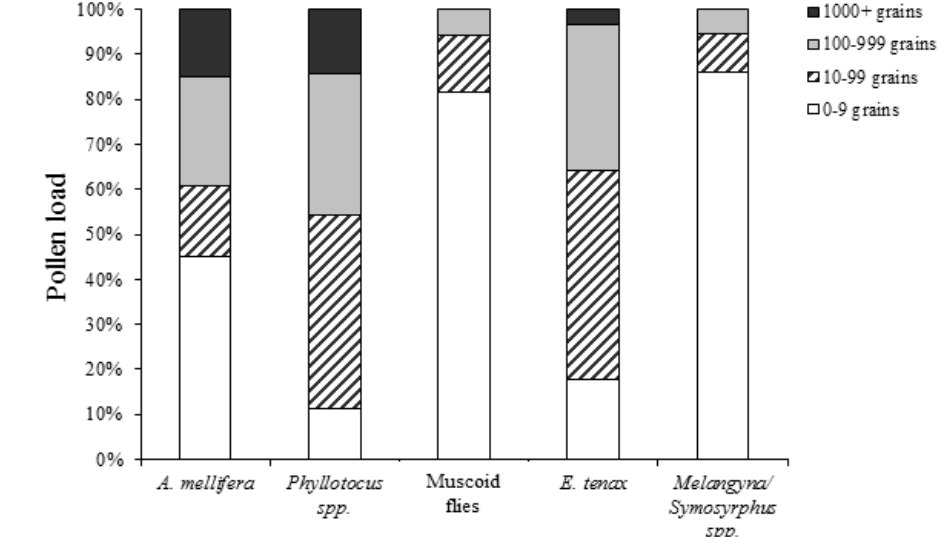
Figure 3. Pollen grains collected from insects in a carrot crop in the first season. Pollen loads are grouped into four categories: 0–9 grains, 10–99 grains, 100–999 grains, and 1000+ grains. Sample size (from left to right) n = 133, 35, 243, 56, and 36.